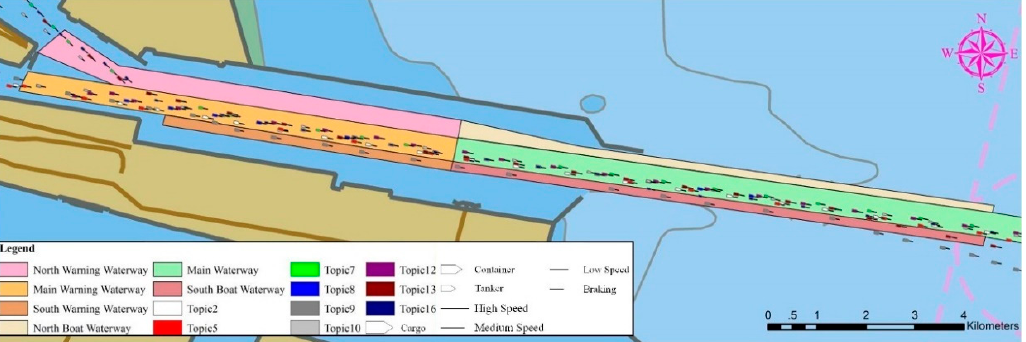
Figure 15. Visualization of the spatial distribution of nine motion pattern topics leaving the Tianjin port waterway.